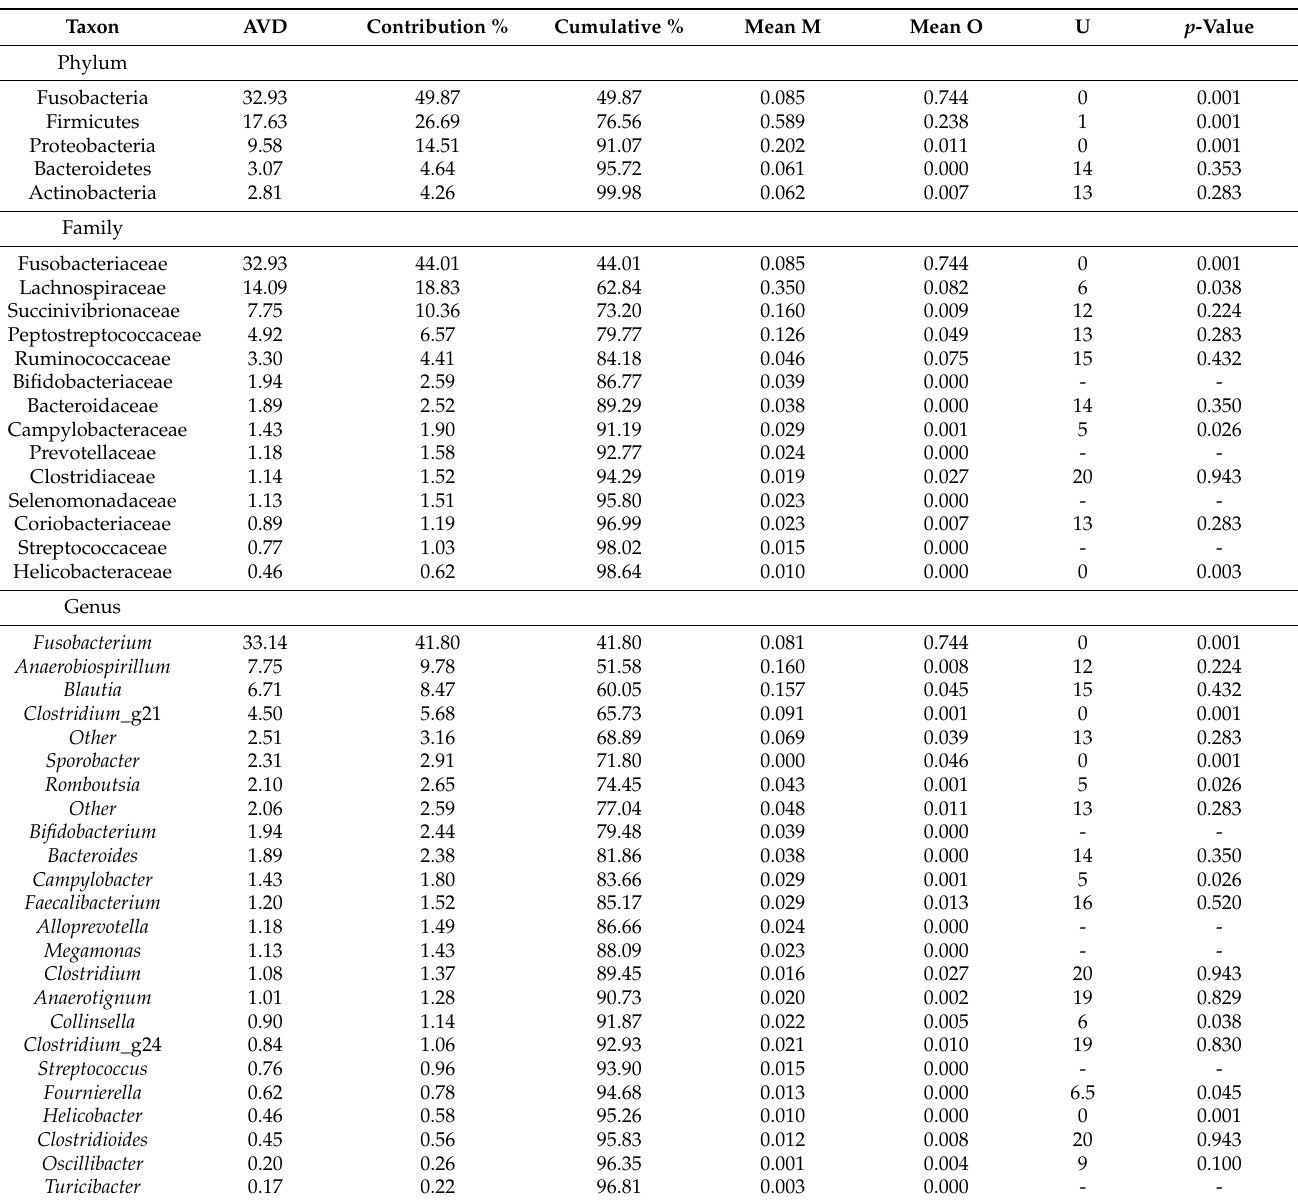
Table 3. Percentage similarity analysis (SIMPER) considering the average of dissimilarity (AVD) of fecal bacteria at phyla, family, and genus levels from two populations of Mexican wolves ( Canis lupus baileyi ) in Michilia (M, 23 ◦ N) and Ocotal (O, 19 ◦ N),